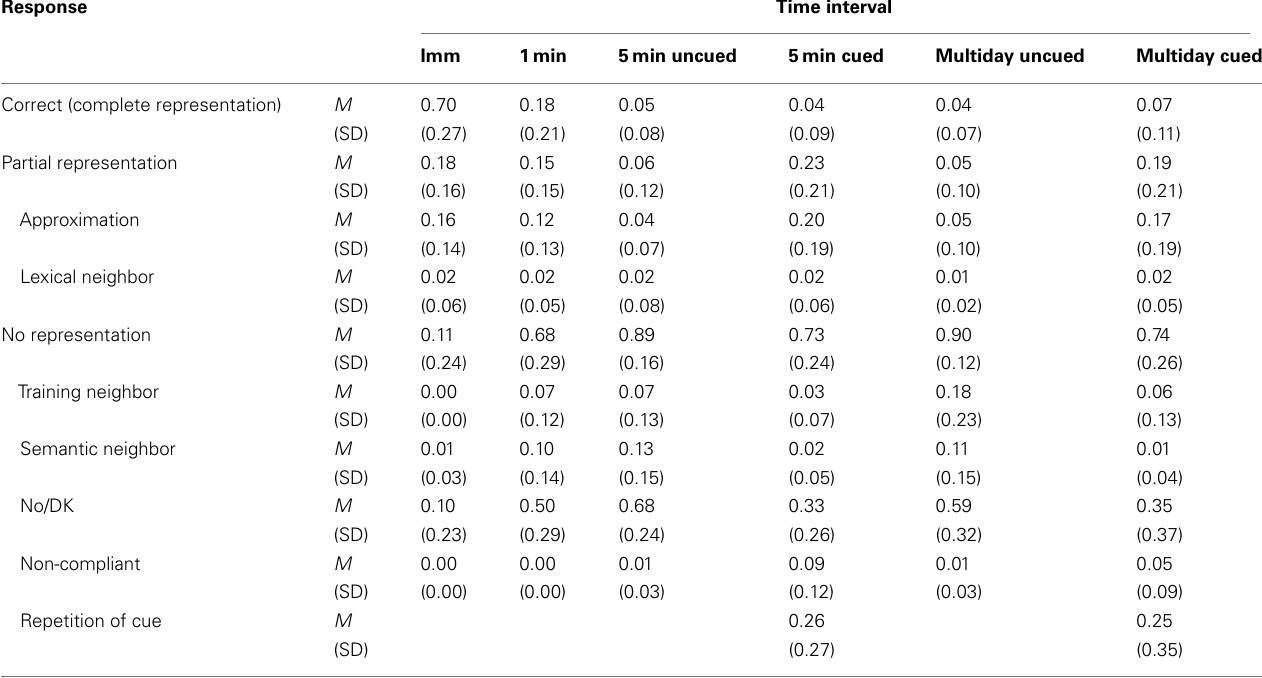
Table 2 | Response types by time